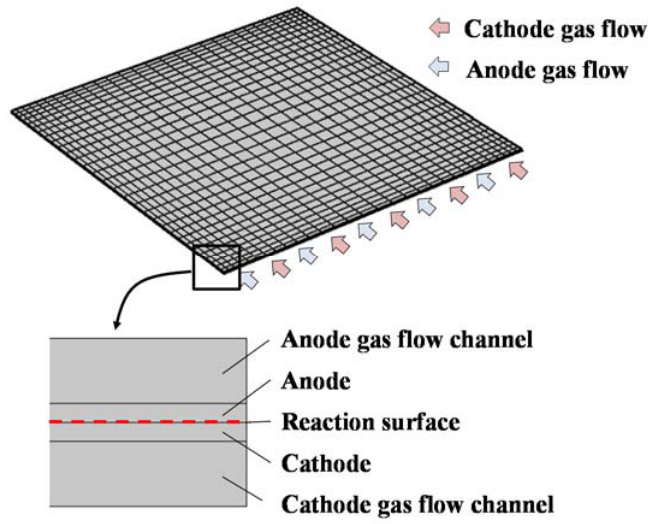
Figure 3. Simulation model of molten carbonate fuel cells (MCFCs).